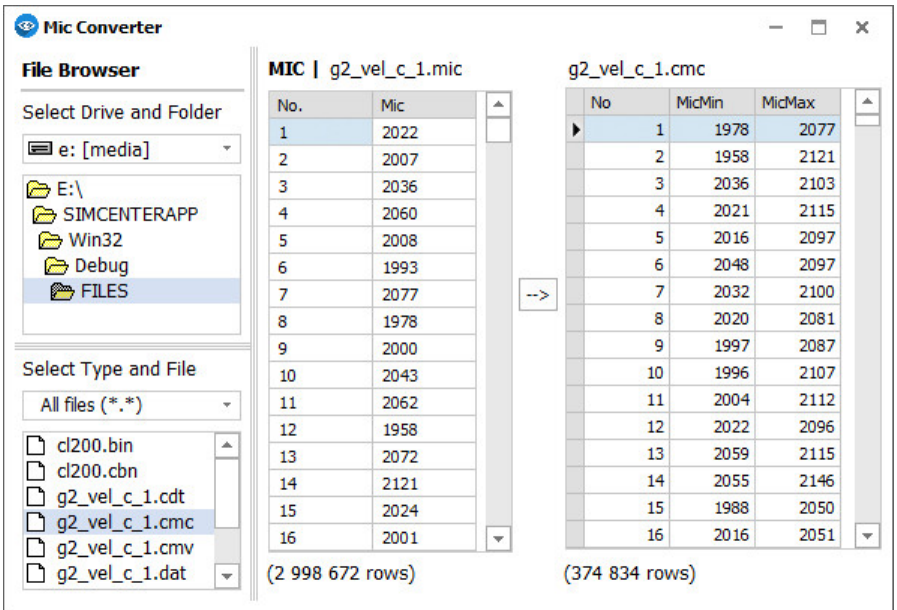
Figure 4. A session of working with the MicConverter module.